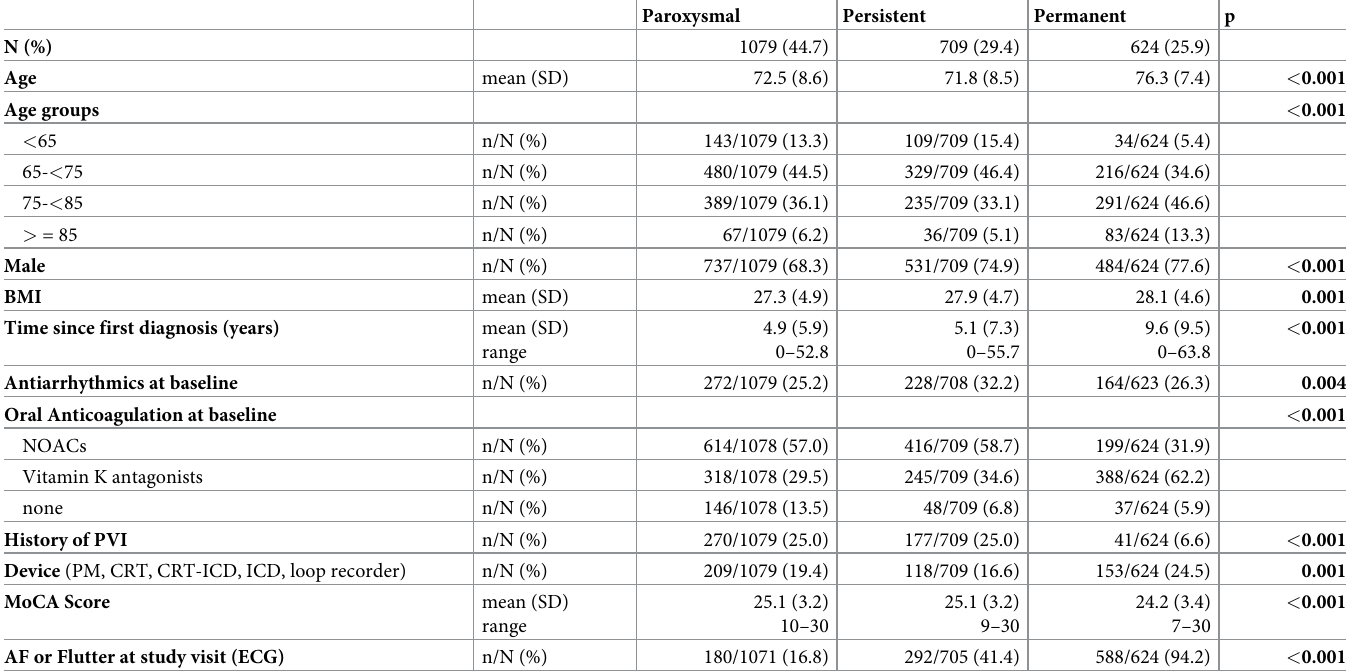
Table 1. Baseline characteristics according to AF type. BMI, body mass index; NOACs, new oral anticoagulants; MoCA, Montreal Cognitive Assessment.